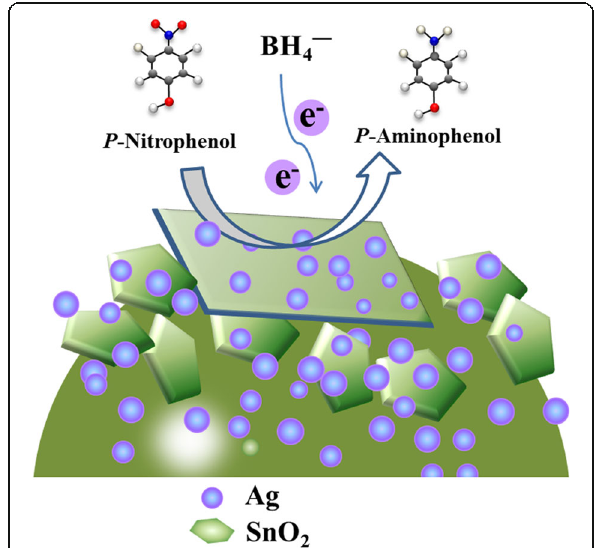
Fig. 10 Schematic illustrations of the catalytic reduction of 4-NP to 4-AP over Ag-decorated SnO 2